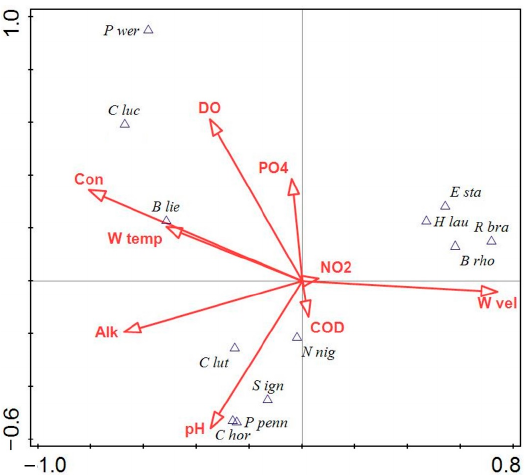
Figure 6. F1 × F2 plane of the Canonical correspondence analysis (CCA) based on 12 mayfly species and nine environmental variables. Abbreviations of the species codes (black triangle symbols) are in Table 1 . Legend: Environmental variables (red arrow symbols): W temp—water temperature (°C), W vel—water velocity (m/s), DO—dissolved oxygen content (mg/L), Con—conductivity (µS/cm), pH—pH, NO2—nitrite concentration (mgN/L), PO4—orthophosphates (mgP/L), COD— chemical oxygen demand (mgO 2 /L), Alk—alkalinity (mg CaCO 3 /L).